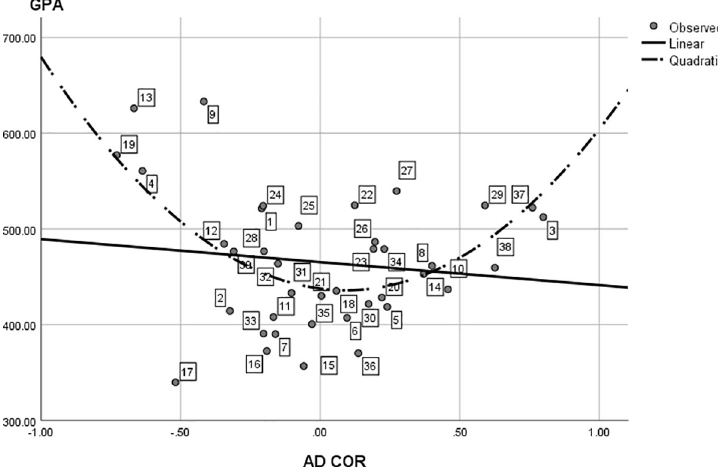
Fig 5. The (curvi-) linear regression of study program average results (GPA) on study program interest diversity. Interest Diversity is measured using AD COR (based on D COR z–scores), with GPA = average grade point average for each study program. The linear regression is depicted as a full line, the quadratic regression is depicted as an interrupted line. The data points (dotted study programs) are labeled analogous to Table 1.